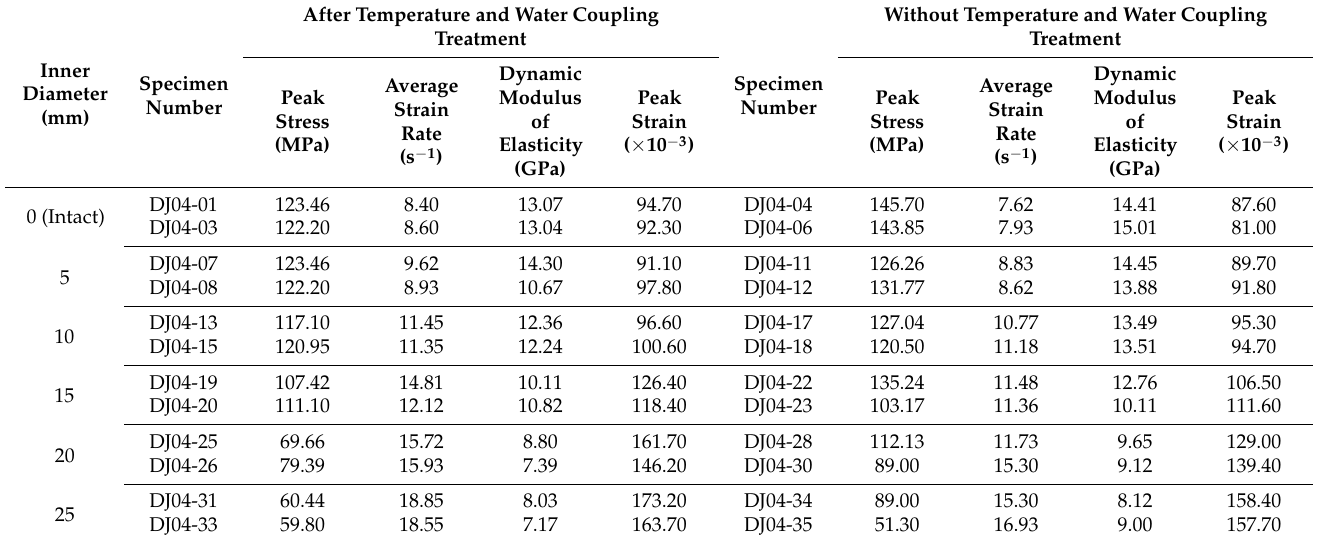
Table 2. SHPB test data.